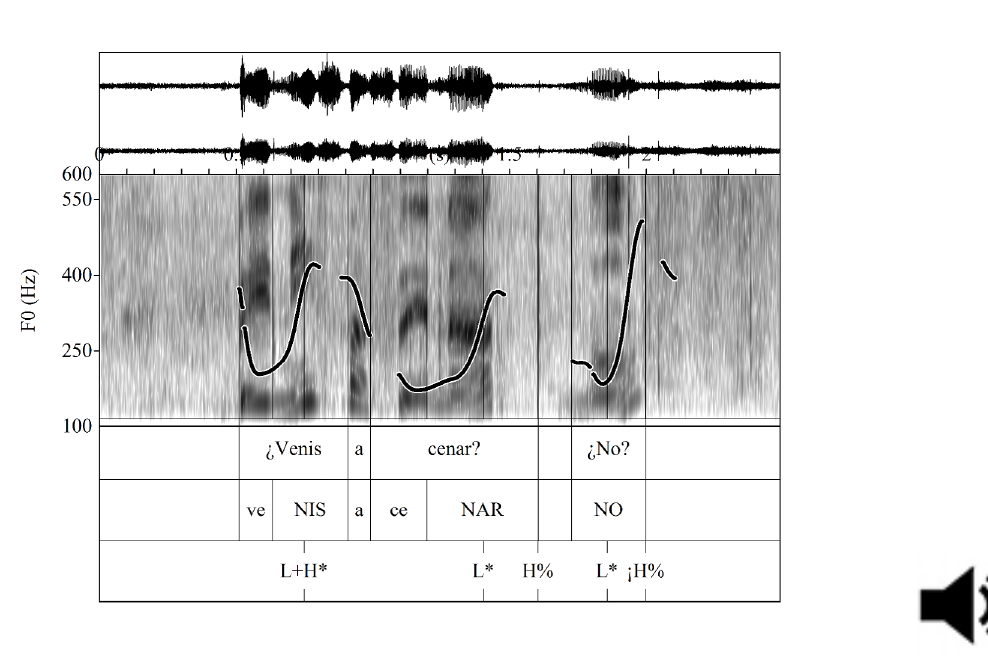
Figure 16 (Participant 4) : Waveform and F0 trace for the confirmatory yes-no question ¿ Venís a cenar, no? ‘Are you coming over for dinner, aren’t you?’ produced as two IPs with L+H* (prenuclear position-1 st IP) and L* H% (nuclear configuration-1 st IP) and L* ¡H% (nuclear configuration-2 nd